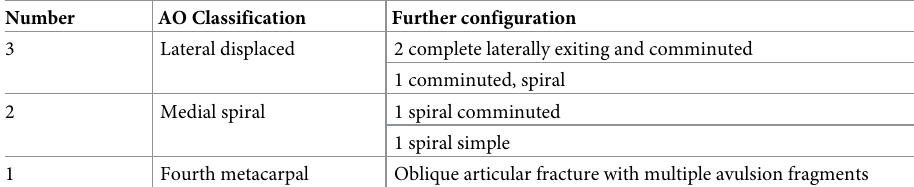
Table 3. Metacarpal bone fractures.